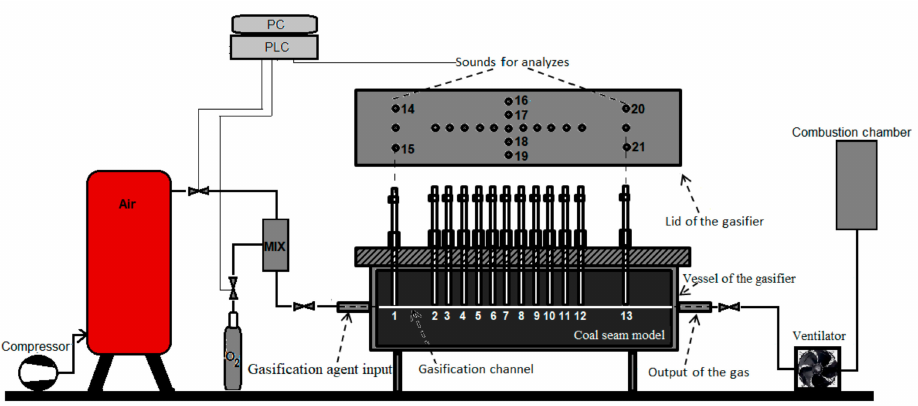
Figure 2. Scheme of the experimental coal gasification system (Source: own